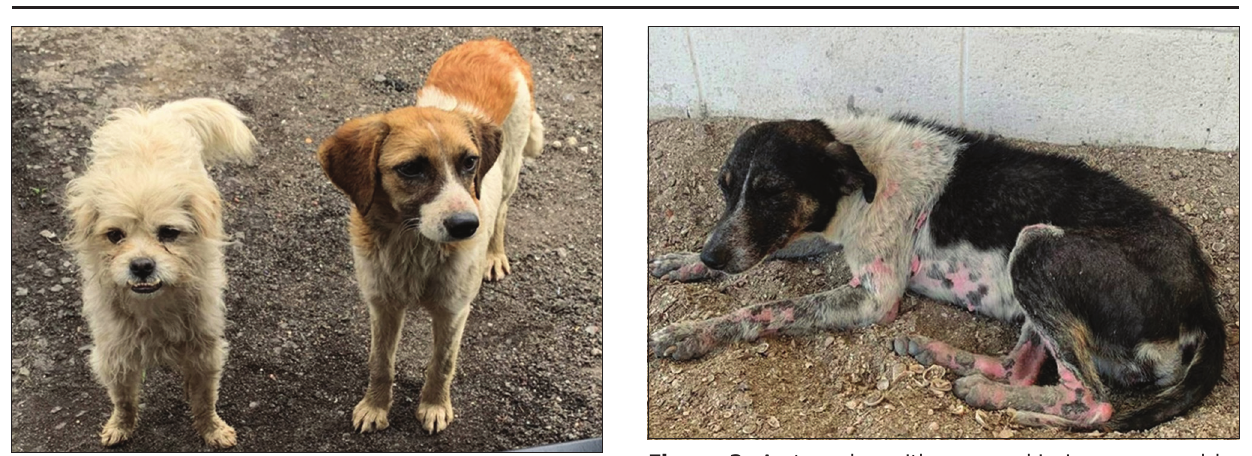
Figure-1: Free-roaming dogs.